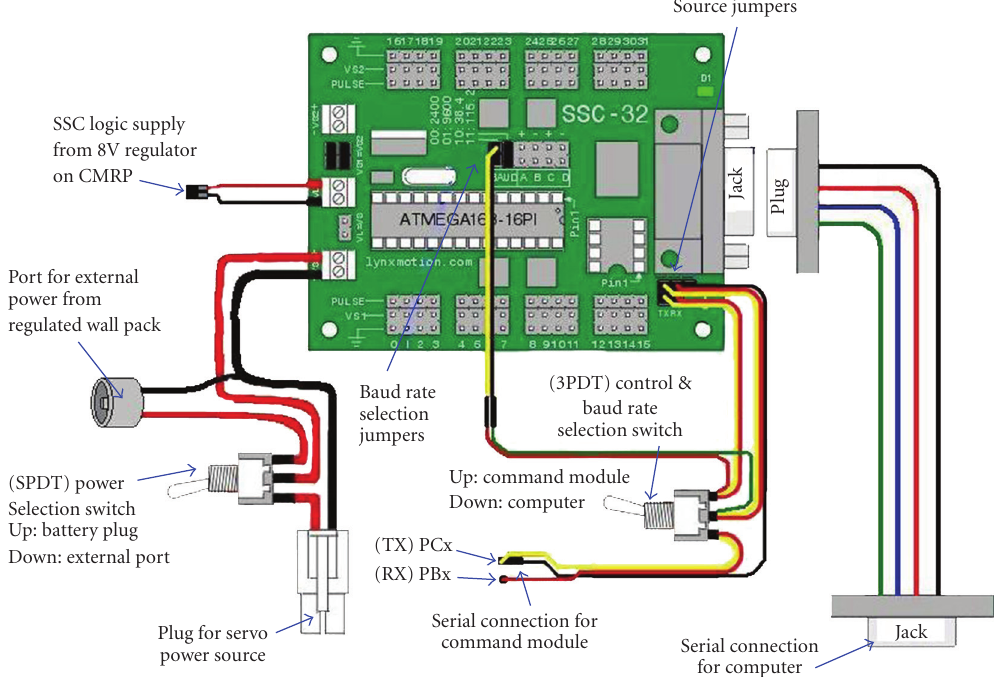
Figure 13: SSC-32 power and control